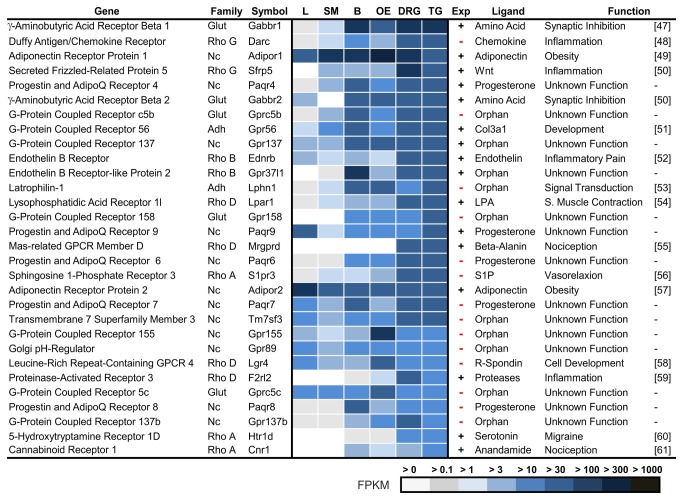
The 30 most highly expressed GPCRs in trigeminalganglia. GPCRs are listed depending on their expression level in the TG and DRG in comparison with the brain (B), liver (L), olfactory epithelium (OE), and skeletal muscle (SM). The FPKM value, which is an indicator of the expression strength, is represented by the color intensity. Exp describes whether the expression in the TG was previously known (+) or unknown (-). To the best of our knowledge, among the 30 most highly expressed genes, 14 GPCRs have not been previously described as expressed in the TG. Most of the detected GPCRs have unknown functions.